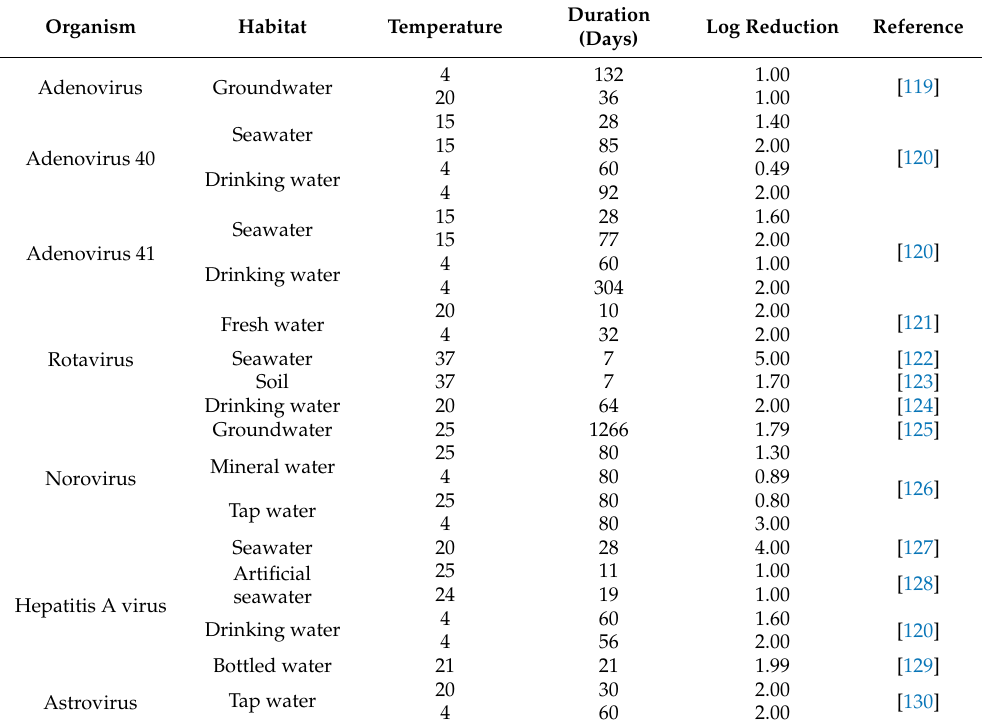
Table 2. Survival of enteric viruses in various water environments.